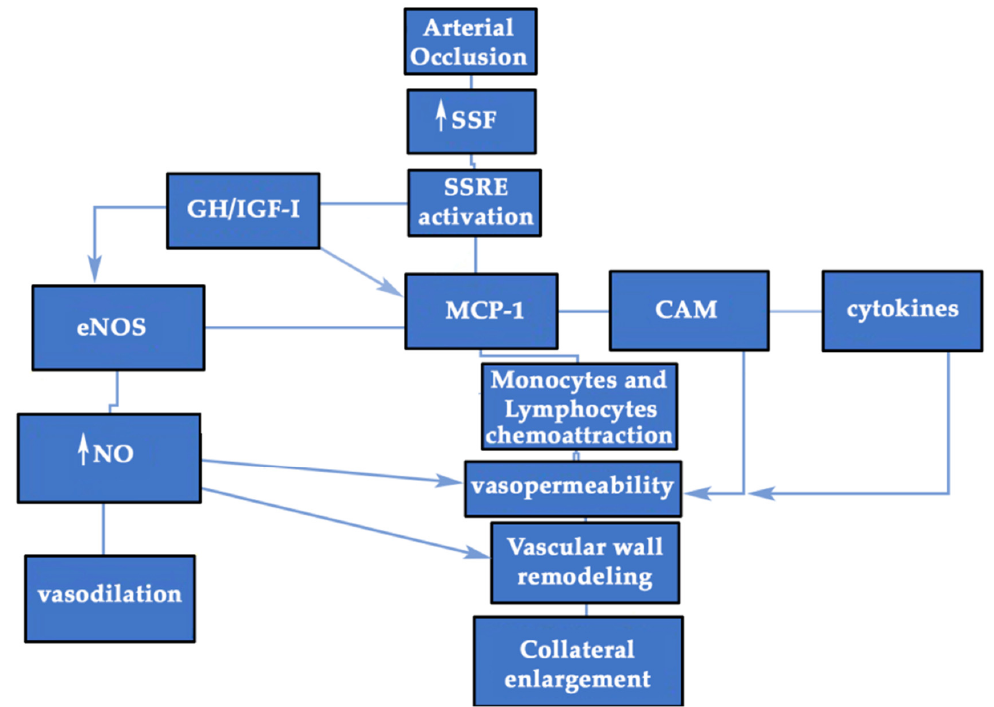
Figure 3. GH/IGF-I are also produced in response to shear stress forces (SSF) for collateral enlargement. Schematic representation of the activation of several molecules after the increase in SSF in which GH and IGF-1 have been added as new elements that enhance these mechanisms. Since GH and IGF-1 are potent mitogenic agents, they have to play a role in the translation of mechanosensing signals. The NO pathway not only is important for vasodilation, as it also has many actions in chemoattraction of inflammatory cells and vasopermeability. The local production of cytokines and hormones seems to be essential for collateral enlargement. SSF: shear stress forces; SSRE: shear stress response elements; eNOS: endothelial nitric oxide synthase; MCP-1: monocyte chemoattractant protein-1; CAM: cellular adhesion molecules; NO: nitric oxide.